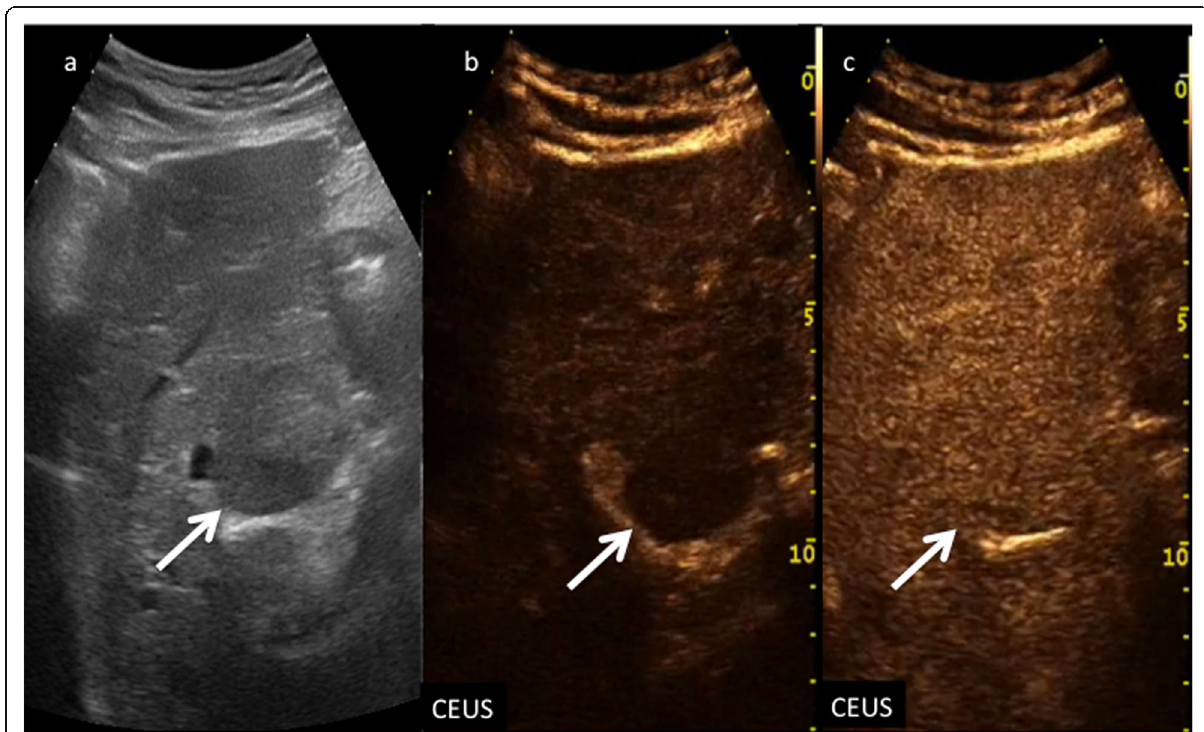
Fig. 7 CEUS LI-RADS 3 (intermediate malignancy probability). Nodule in a 74-year-old man with virus B-related cirrhosis. Baseline US image ( a ) shows a slightly hypoechoic lesion sized 3 cm in the segment IV (arrow). At CEUS, the nodule appears moderately hypoechoic during the arterial phase ( b ) and isoechoic to the adjacent liver parenchyma in the extended portal venous ( c ) phase